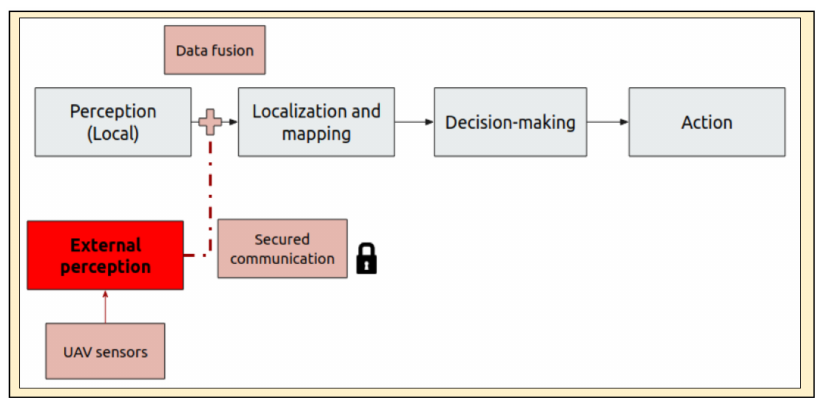
Figure 2. Perception enhancement of the autonomous navigation